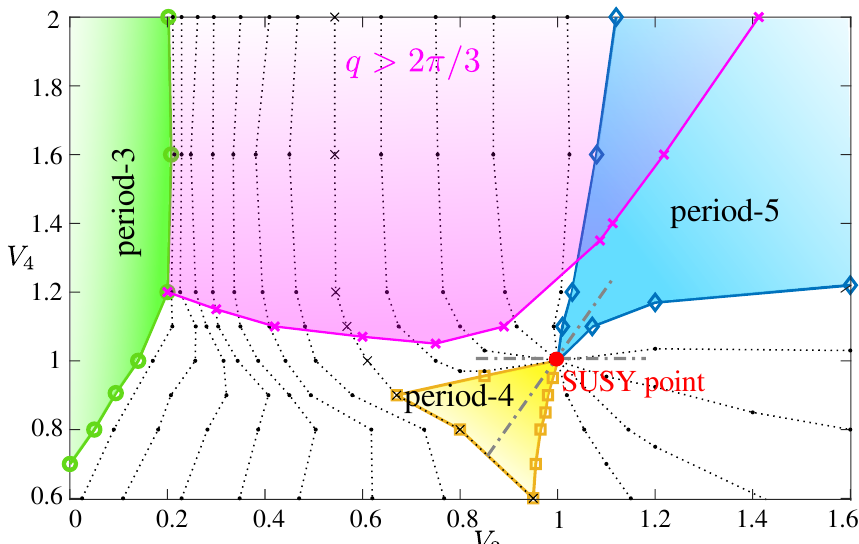
Figure 10: Phase diagram of Fig. 2 with indicated region (magenta), where the dominant ground state density wave vector q > 2 π/ 3. Dash-dotted lines indicate